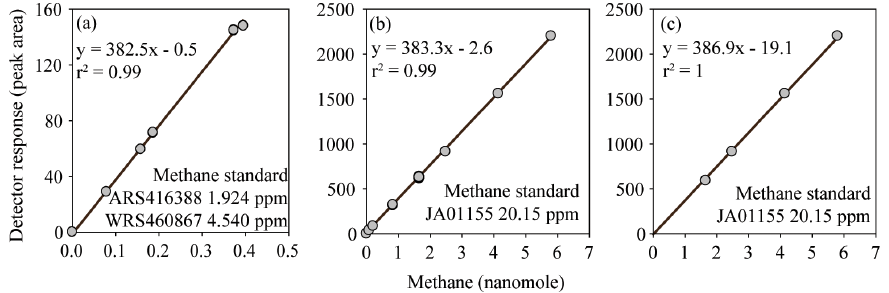
Figure 3. FID response to methane fitted with a linear regression calibration. The inclusion (a, b) or exclusion (c) of low methane values causes the calibration slope and intercept to vary. However, the observed variation in the calibration slope does not have a significant effect on the final calculated concentrations of methane. In contrast, variation in the intercept does have an effect on the final concentrations of